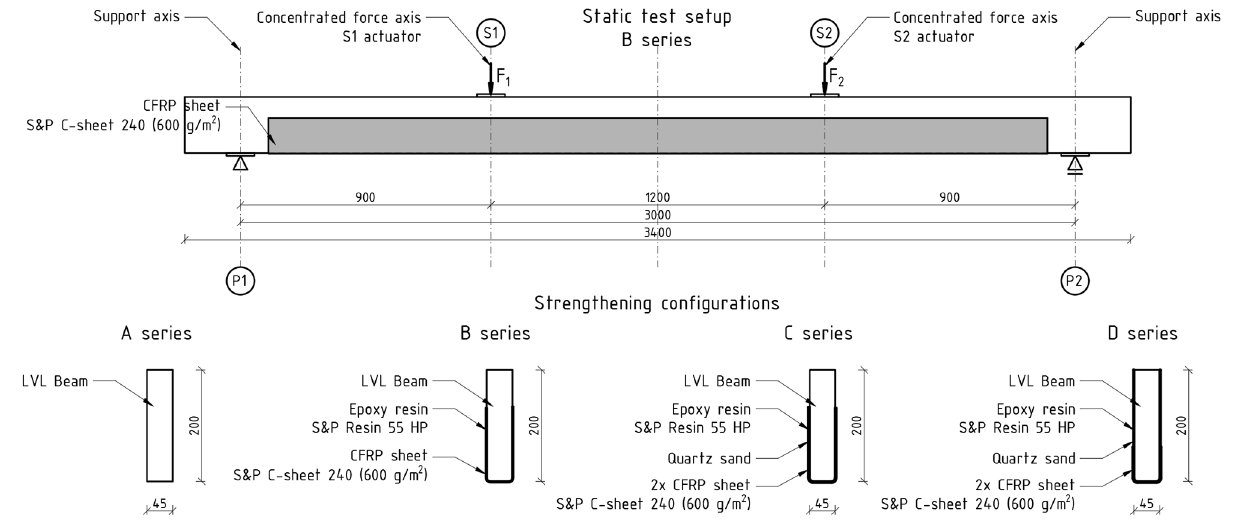
Figure 1. Strengthening configurations and schematic of the test setup.